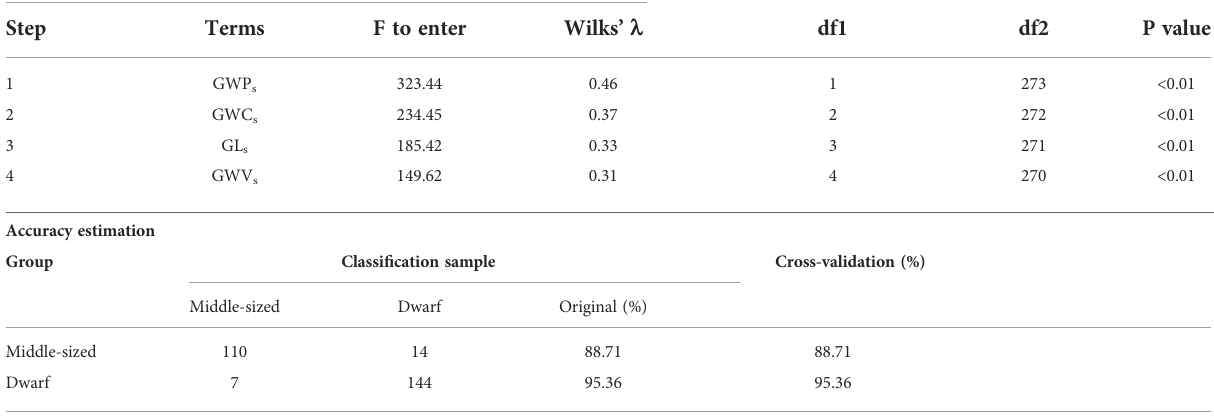
TABLE 3 The results of stepwise discriminant analyses for the gladius morphometric characteristics of the dwarf without a dorsal photophore and middle-sized typical forms Sthenoteuthis oualaniensis in the South China Sea. Stepwise discriminant